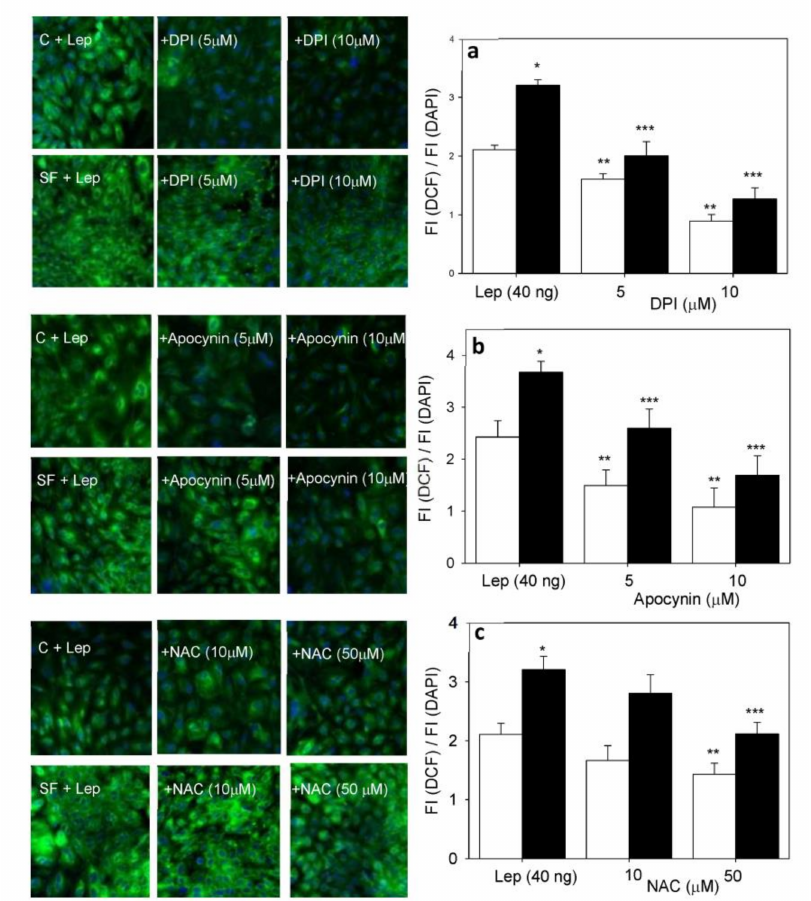
Figure 2. The effect of DPI, apocynin and NAC on leptin-induced ROS generation in aortic SMCs. In all panels, white bar corresponds to C cells and black bar corresponds to SF cells. the representative microscopic images of C and SF SMCs incubated with DCF (Green) and DAPI (Blue). Aortic SMCs from both C and SF rats were pre-incubated with 5 and 10 µ M DPI (panel ( a )) and apocynin (panel ( b )) as Nox inhibitors, and with 10 and 50 µ M N-acetyl-cysteine (NAC) as a reducing agent (panel ( c )). After 30 min preincubation with inhibitors and scavenger, aortic SMCs were treated with 10 µ M DCF-DA and 15 min later with leptin at 40 ng/mL culture medium for 15 more minutes. The values correspond to the ratio of the intensity of fluorescence emitted by DCF in cell (DCF FI) to the intensity of fluorescence of DAPI in cell (DAPI FI) +/ − SD (n = 4 different experimental animals). * p < 0.05 corresponds to C + Lep vs. SF + Lep, ** p < 0.05 corresponds to C + Lep vs. C + Lep + DPI, *** p < 0.05 corresponds to SF + Lep vs. SF + Lep +